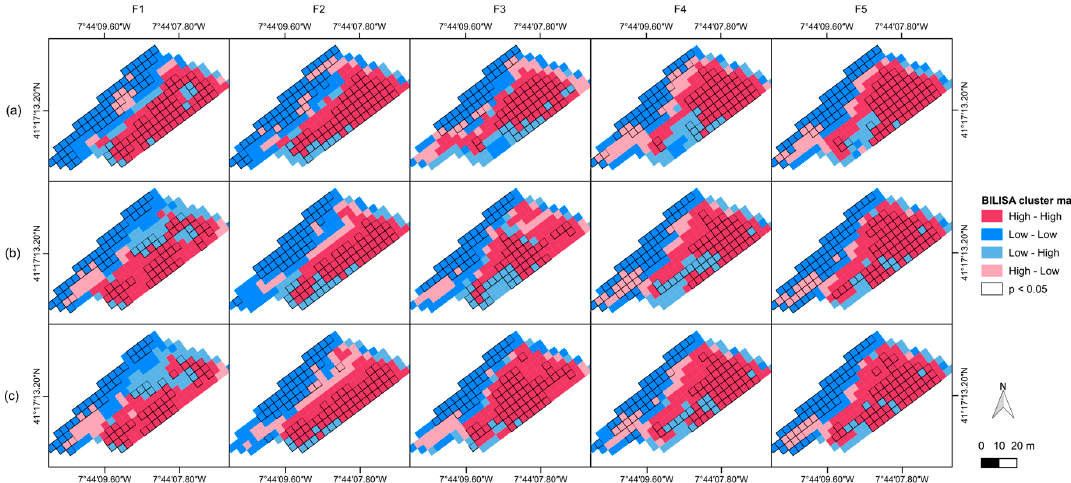
Figure 11. BILISA cluster maps between NDVI vigour maps and CSM height maps for the three evaluated approaches: ( a ) first approach, ( b ) second approach, and ( c ) third approach. Associations with a p -value < 0.05 are highlighted with a black border.